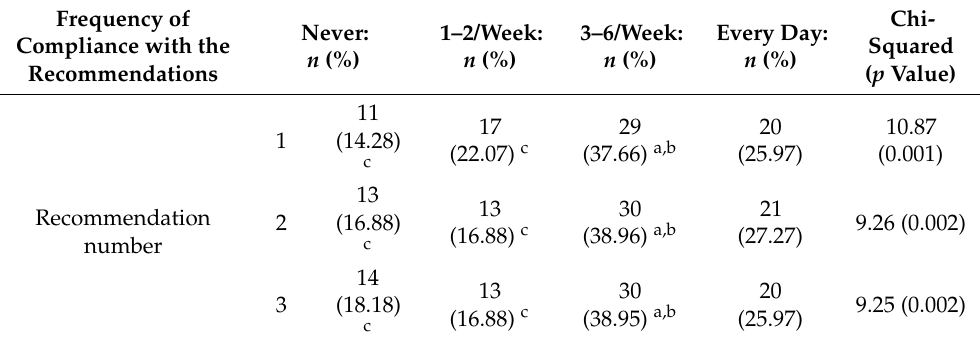
Table 3. Frequency of compliance with the recommended health-related recommendations ( n =